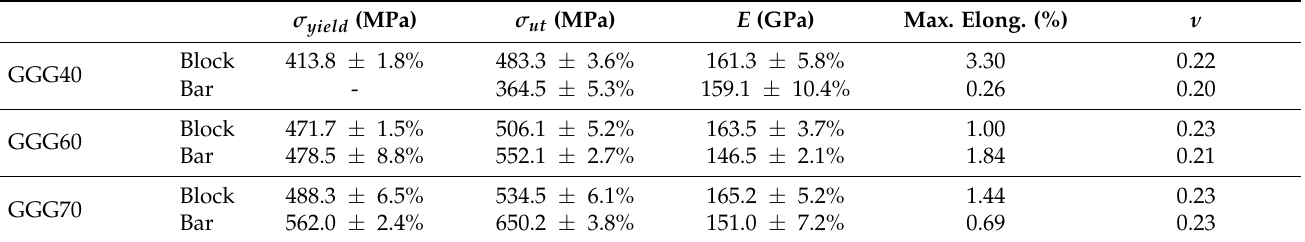
Table 7. Final tensile test results averages for NCI GGG40, 60 and 70 bar and block specimens. σ yield (MPa) σ ut (MPa) E